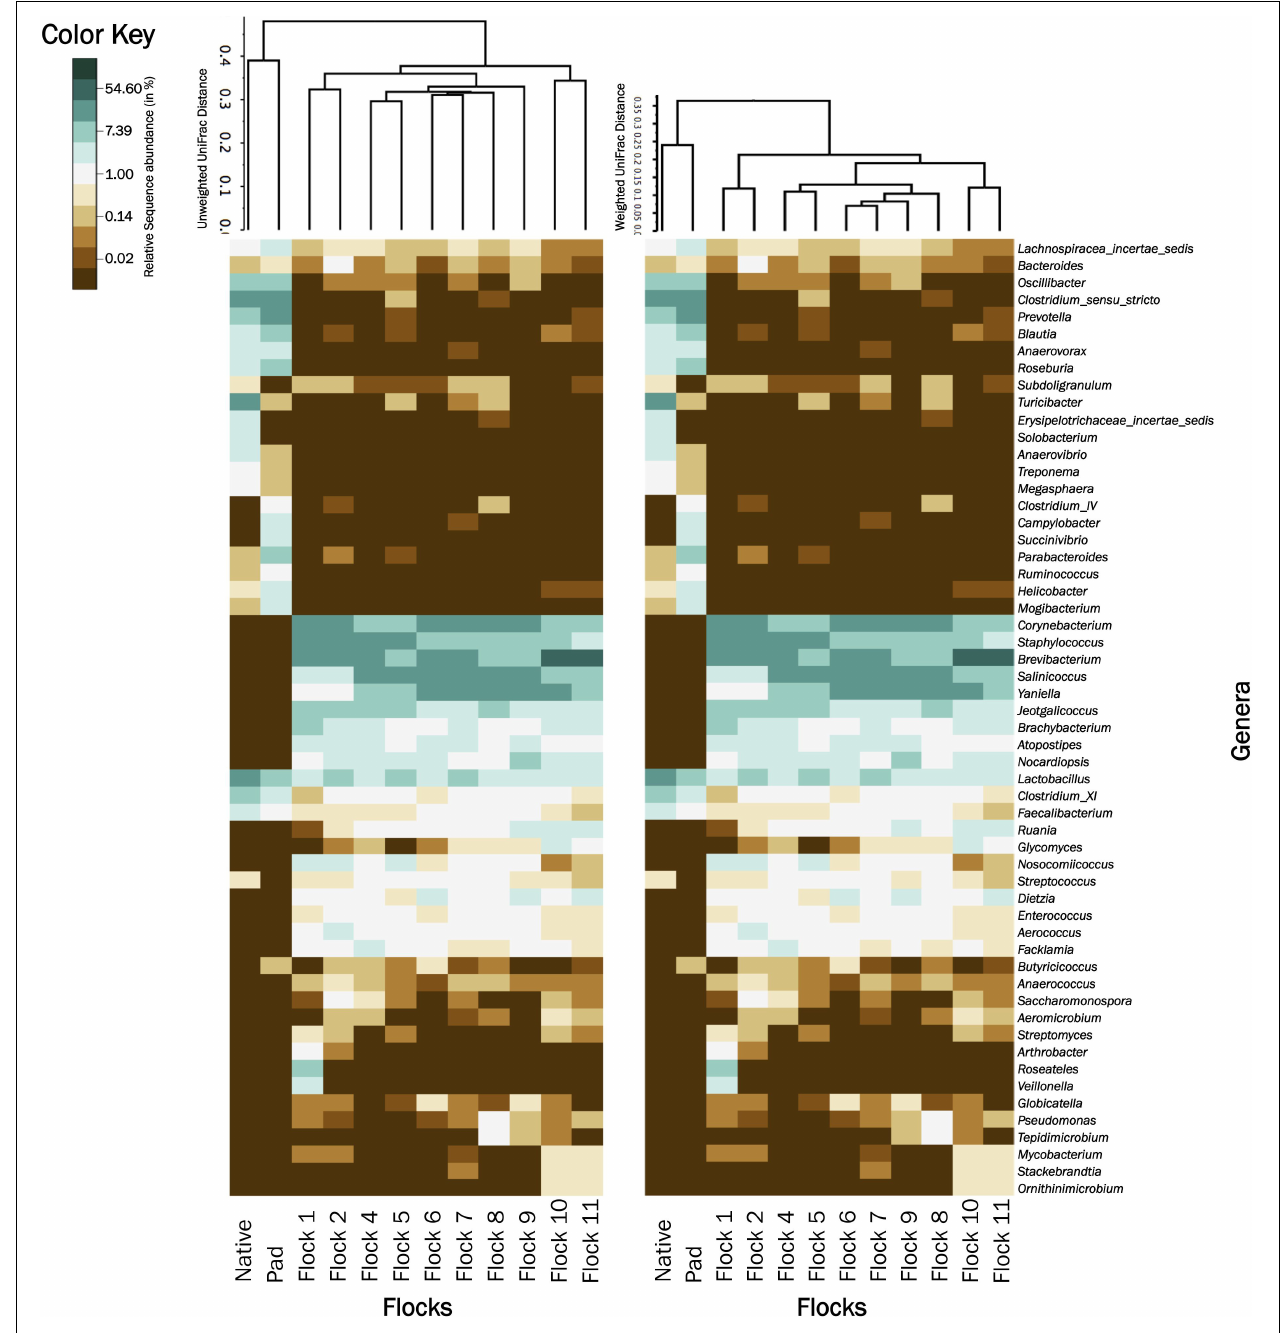
FIGURE 5 | A heatmap of bacterial genera associated with Native, Pad, and Flock samples. For better visualization, relative abundance values were natural log transformed. For natural log transformation, “0” was converted into “0.01.” Samples were clustered based on unweighted (left) and weighted (right) Unifrac